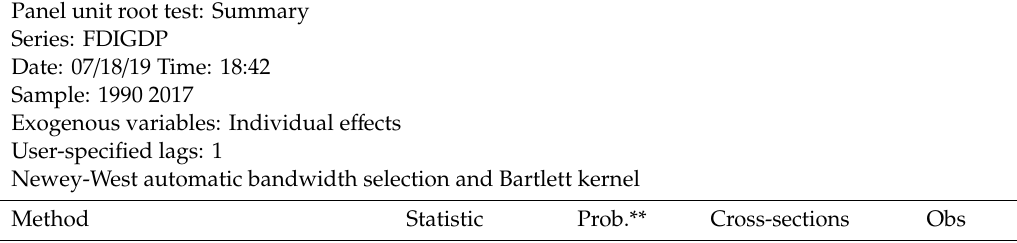
Table A1. Panel Unit Root Test for FDIGDP variable.